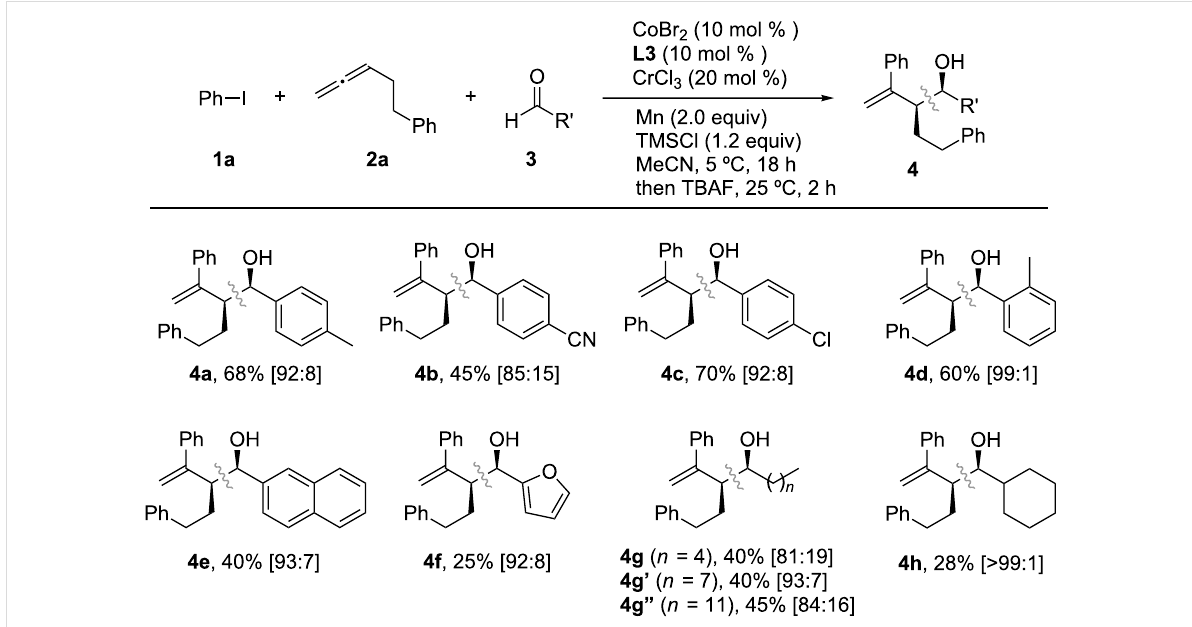
Scheme 6: Screening of aldehydes in the Co/Cr-catalyzed three-component coupling reaction. All yields are determined after isolation. The values in brackets indicate the diastereomer ratio of the syn and anti products, determined from 1 H NMR